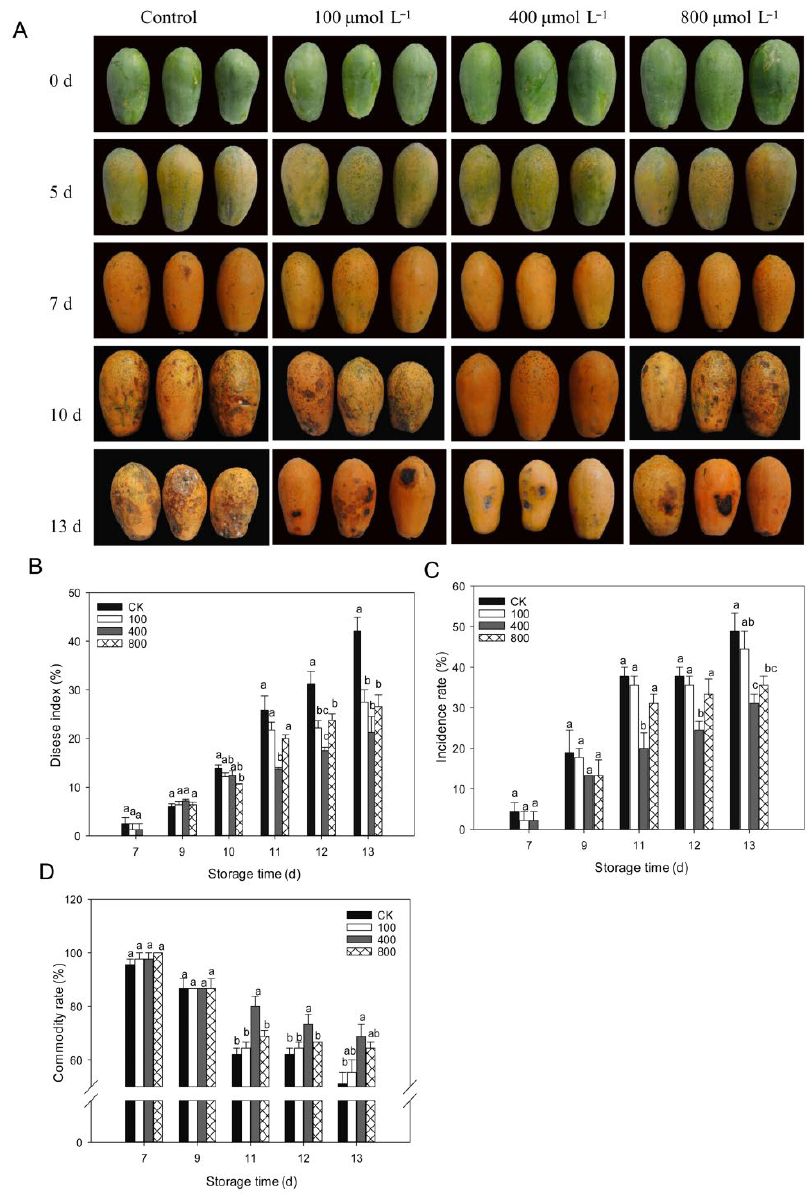
Figure 2 . Impact of melatonin application on fruit disease incidence. ( A ) Pictorial view of papaya fruits during various melatonin applications. ( B ) Fruit disease index. ( C ) Fruit disease incidence. ( D ) Fruit commodity rate. Papaya fruit were stored at room temperature (25 ± 1 °C) after treatment. The data are shown as mean ± SE ( n = 3) and different letters represent the significant differences at the 5% level. CK: control group, “100”, “400” and “800” indicated the “100 μmolL − 1 ”, “400 μmolL − 1 ” and “800 μmolL − 1 ” melatonin treatments.